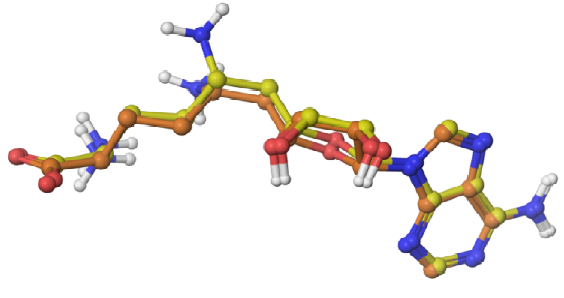
Figure 3. Validation of the docking protocol: comparison of the co-crystal (yellow) vs . predicted (orange) binding mode of sinefungin with Glide XP.